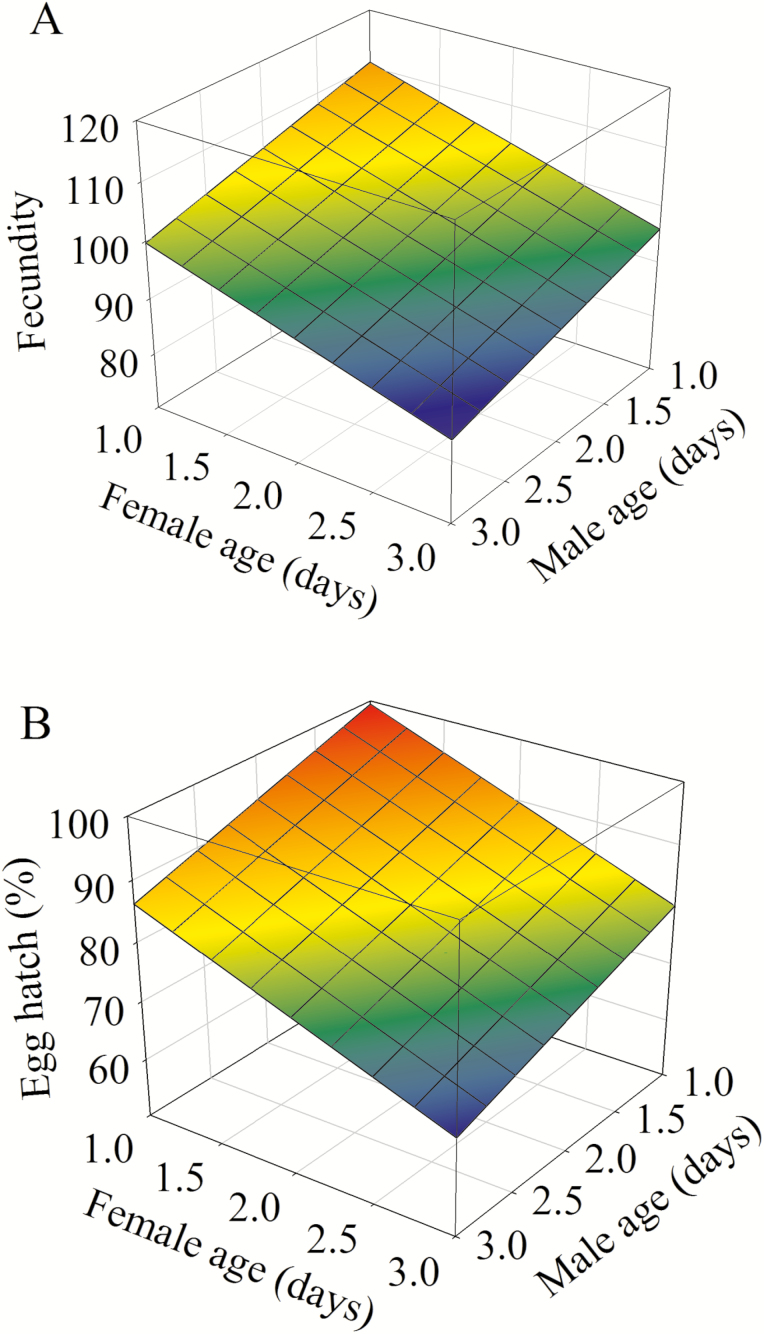
Effects of female and male age on fecundity and egg hatch (%) in P. ﬂammans. (A) fecundity = 123.81 – 5.54 × male age—7.48 × female age (F = 15.79; df = 2, 145; P < 0.001; R2 = 0.179); (B) egg hatch (%) = 97.32 – 2.62 × male age—3.63 × female age (F = 12.78; df = 2, 145; P < 0.001; R2 = 0.150).